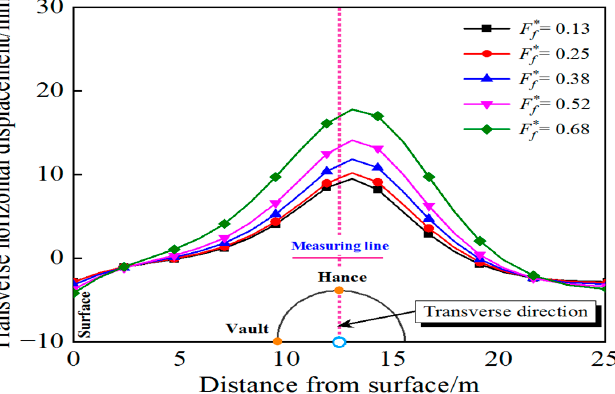
Figure 21. Horizontal deformation of the stratum along the transverse direction under different friction coefficients F ∗ . f